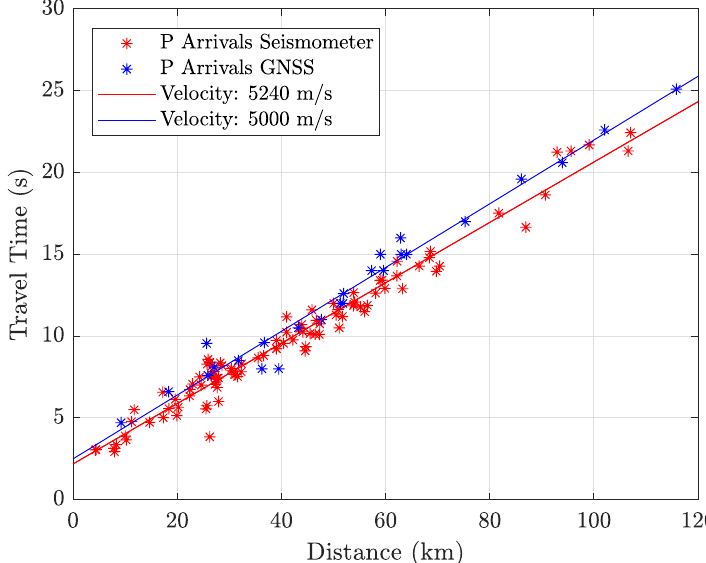
Figure 5. Travel times and velocities of P-wave arrivals obtained for GNSS, and for all seismometer stations, respectively. There is a tendency for the GNSS arrivals to be detected with a small delay compared to the first arrivals of the